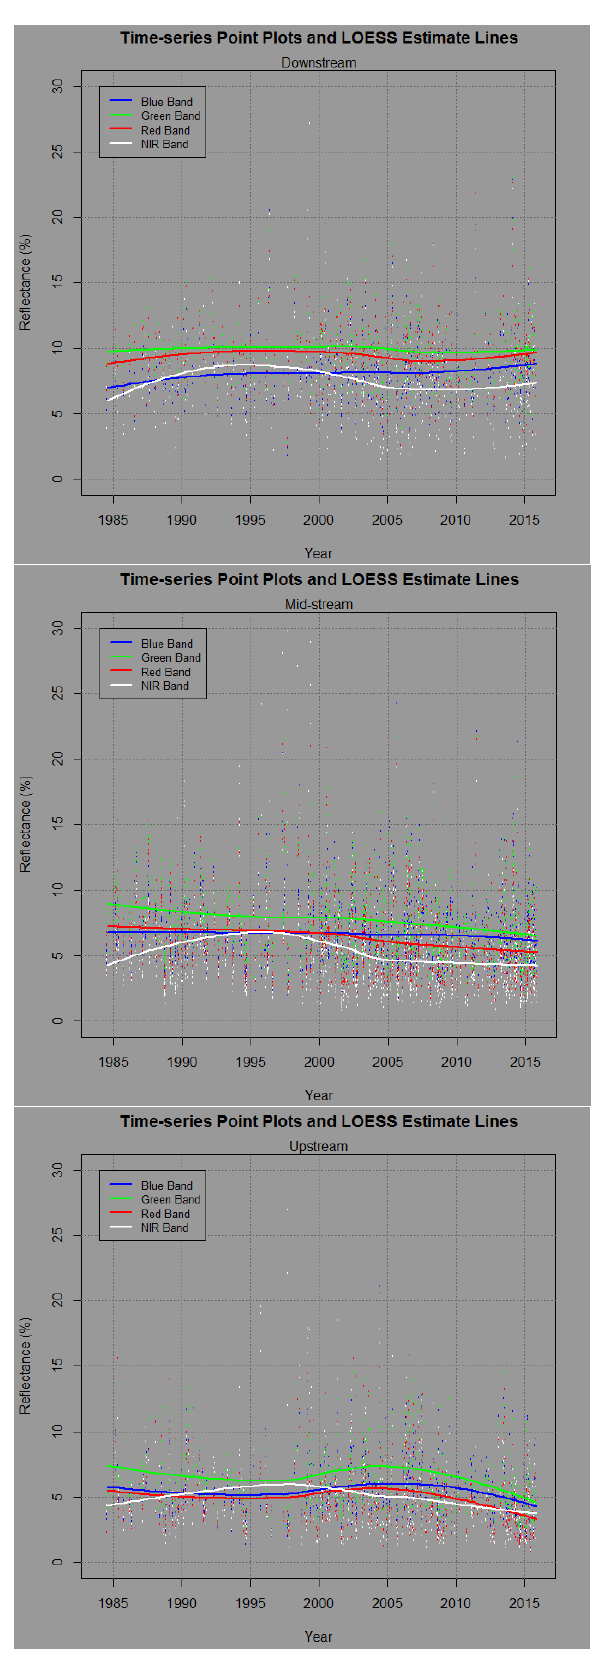
Figure 3. Temporal change of reflectance values at the Downstream, Mid-stream and Upstream areas